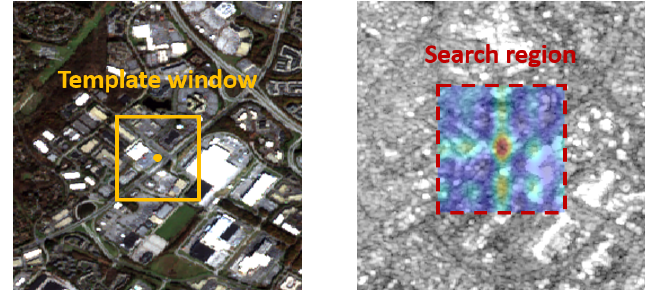
Figure 6. The similarity map of the correct